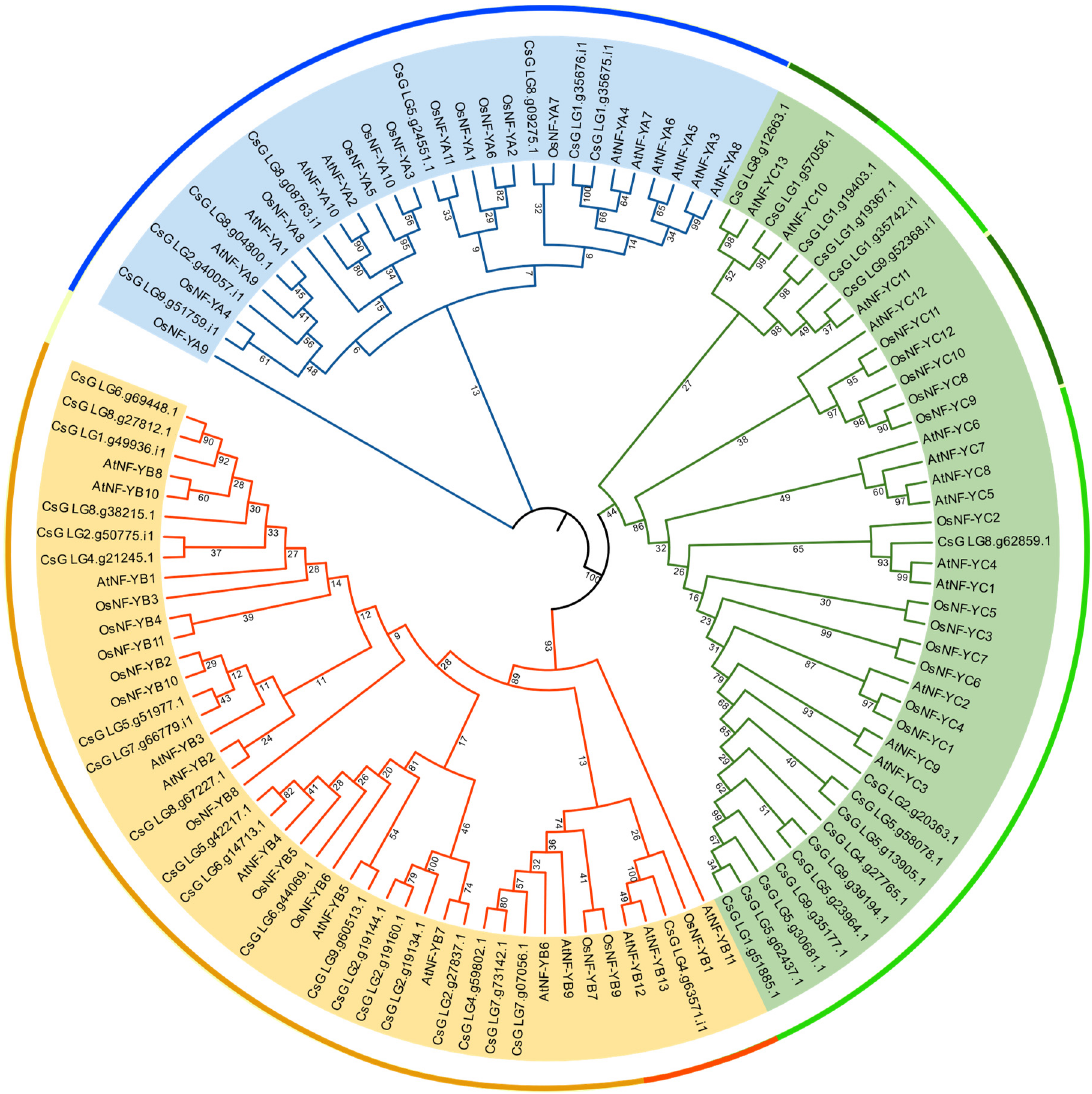
Figure 1. Phylogenetic analysis of NF-Y protein from C. seticuspe , A. thaliana , O. sativa . Full-length protein sequences of NF-Ys were used to construct the tree by using MEGA-X based on the maximum-likelihood (ML) method. Subfamily are highlighted with different colors. The blue represents NF-YA subfamily, the orange represents NF-YB subfamily, and the green represents NF-YC subfamily.